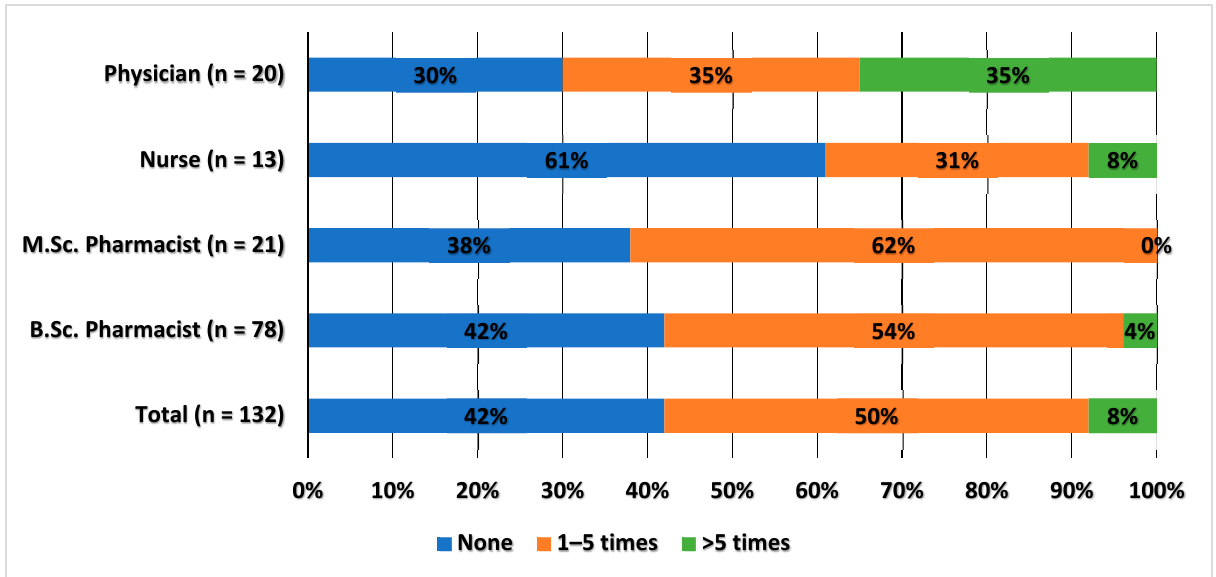
Figure 1. Adverse drug reaction reporting experience among healthcare professionals, percentage (%) of HCPs. Questionnaire question: During your career, how many times have you reported a suspected adverse drug reaction to the local health authority (Finnish Medicines Agency) or the marketing authorization holder?